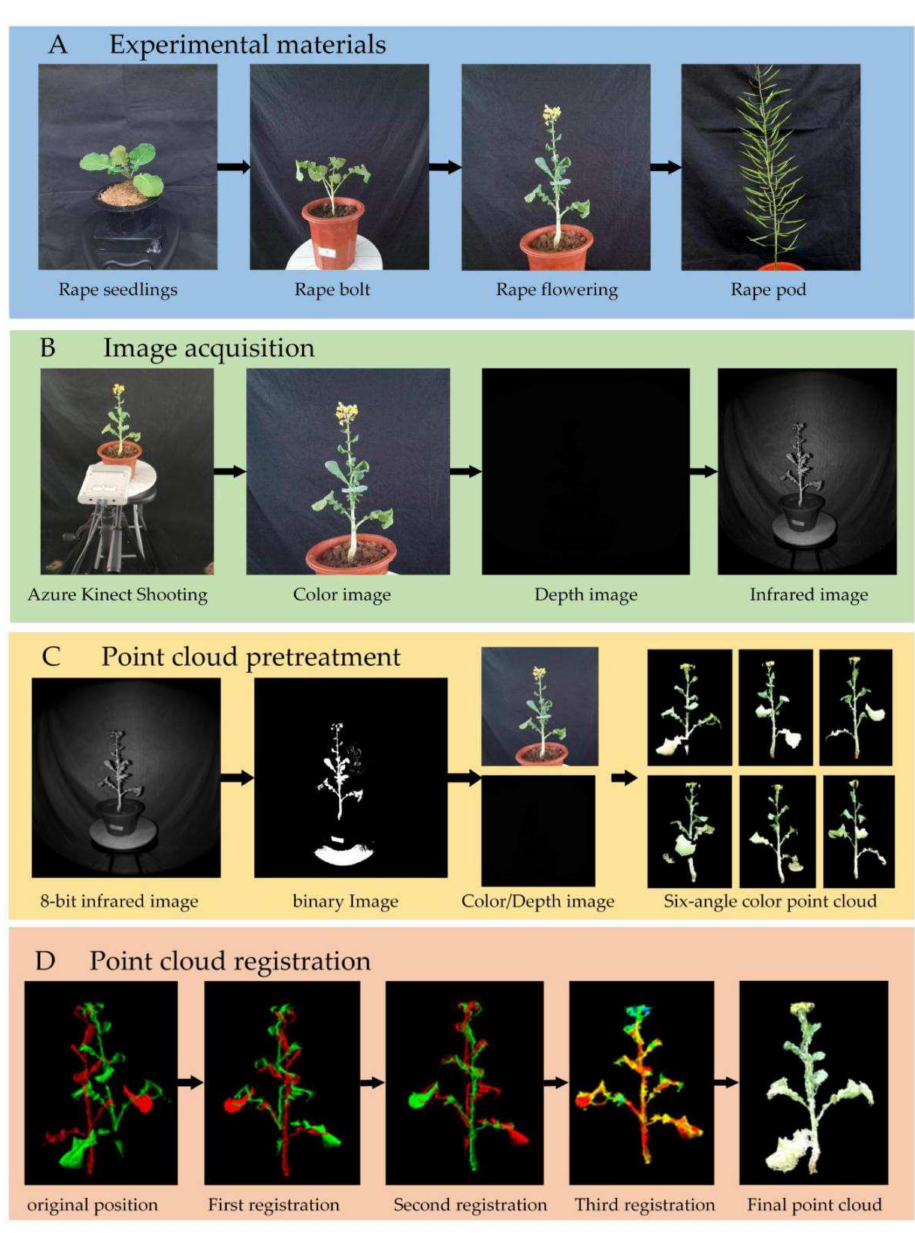
Figure 2. The program flow chart of this